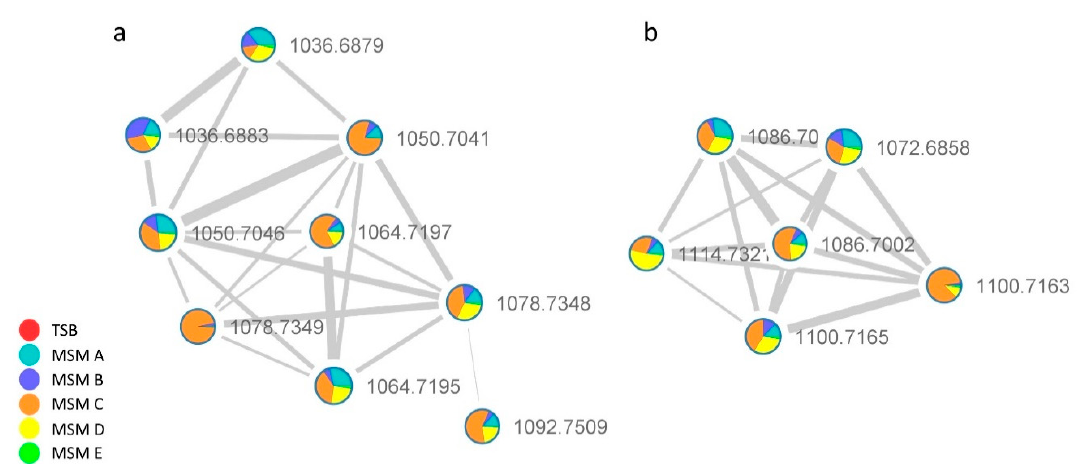
Figure 3. Surfactins ( a ) [M + H] + and ( b ) [M + Na] + adduct clusters. Color chart shows that they are only produced in the media containing inorganic nitrogen sources.